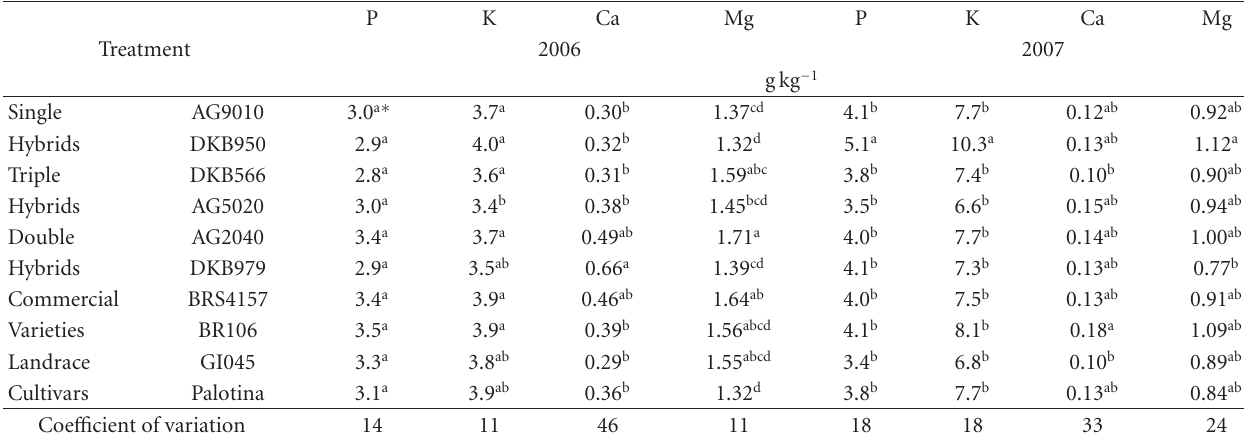
Table 2: Grain macronutrient concentration in ten corn cultivars representing five di ff erent technological levels in 2006 and 2007, at Rolandia County, Parana State,